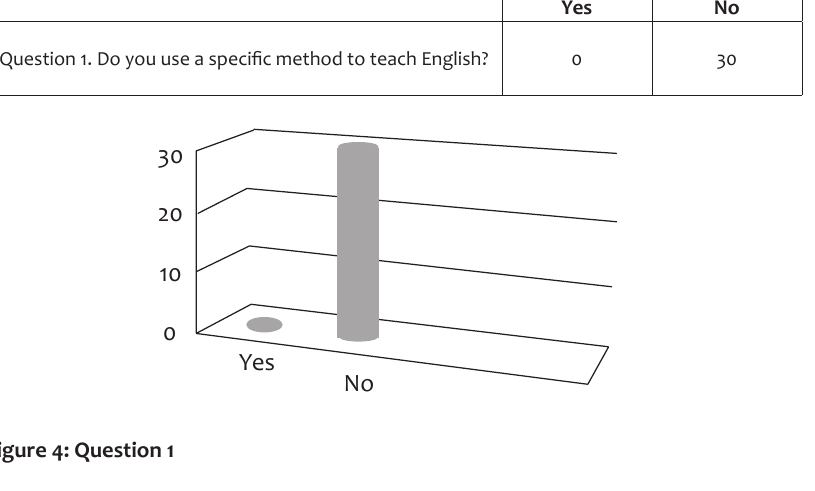
Table 4 and Figure 4 show that all the teachers did not use a specific method for teaching first additional